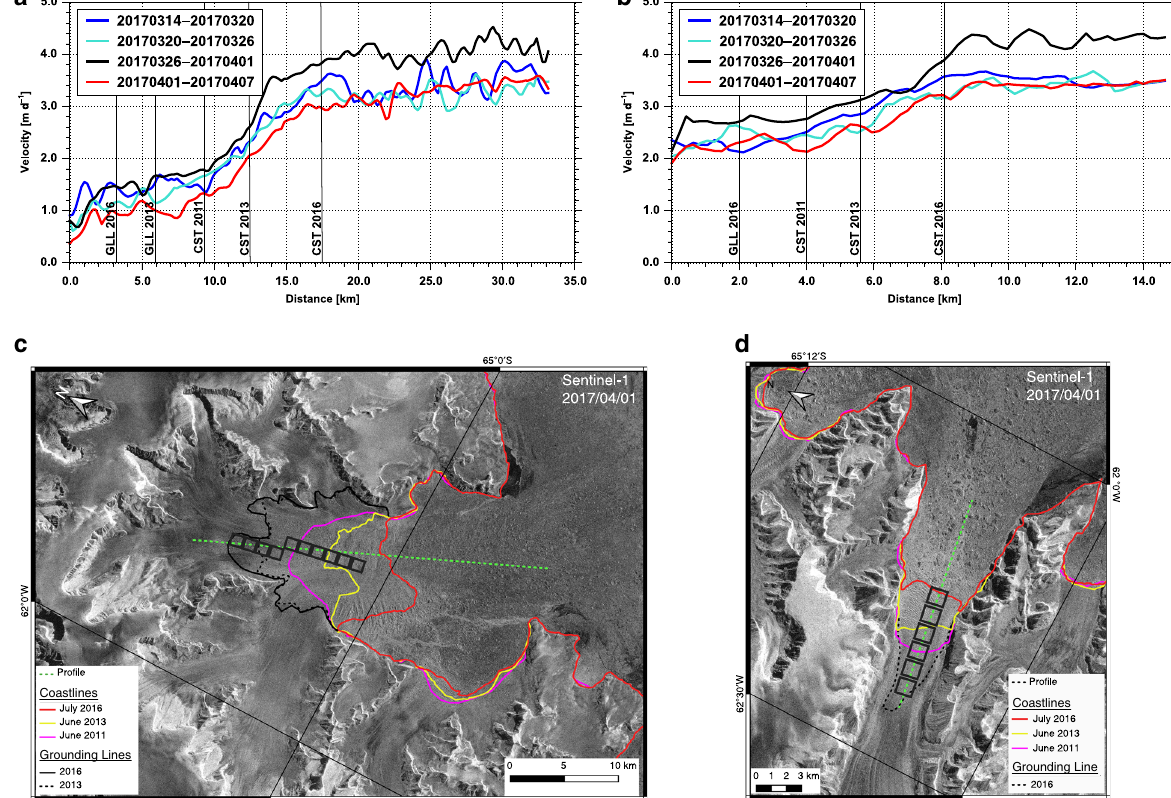
Fig. 2 Velocity transects during a down-slope wind event. Velocity transects along central fl owlines, extending from grounded ice to fl oating ice and ice mélange for Hektoria Glacier ( a ) and Crane Glacier ( b ) before, during and after the acceleration event of 2017-03-26 to 2017-04-01. GLL – Location of the grounding line; CST – glacier front in 2011, 2013, 2016. c and d : Sections of Sentinel-1 image of 2017-04-01 showing the location of the velocity transects on Hektoria Glacier ( c ) and Crane Glacier ( d